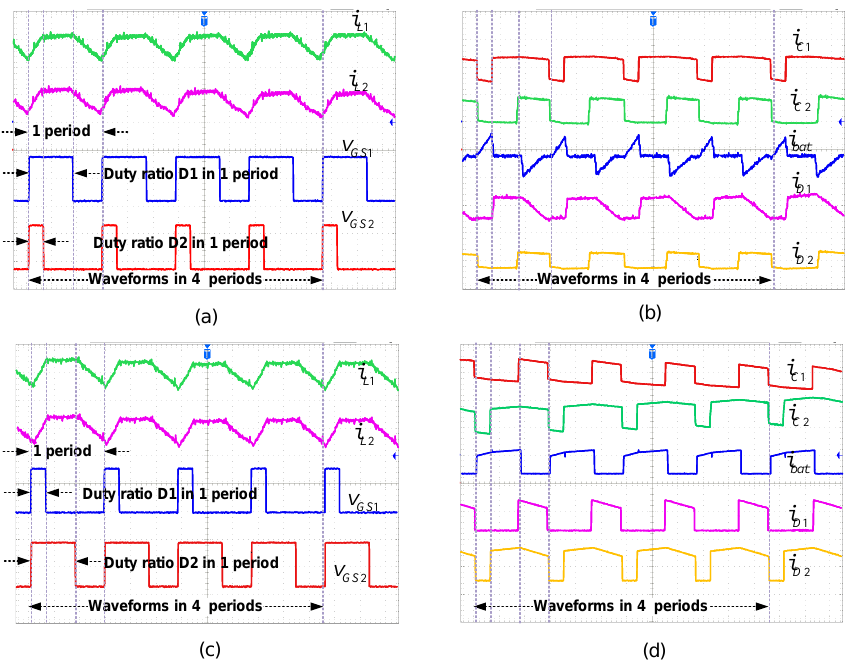
Figure 9. Steady-state waveforms of ( a ) v g 1 , v g 2 , i L 1 , i L 2 when D 1 > D 2 , ( b ) i C 1 , i C 2 , i bat , i D 1 , and i D 2 when D 1 > D 2 , ( c ) v g 1 , v g 2 , i L 1 , i L 2 when D 1 < D 2 , ( d ) i C 1 , i C 2 , i bat , i D 1 , and i D 2 when D 1 < D 2